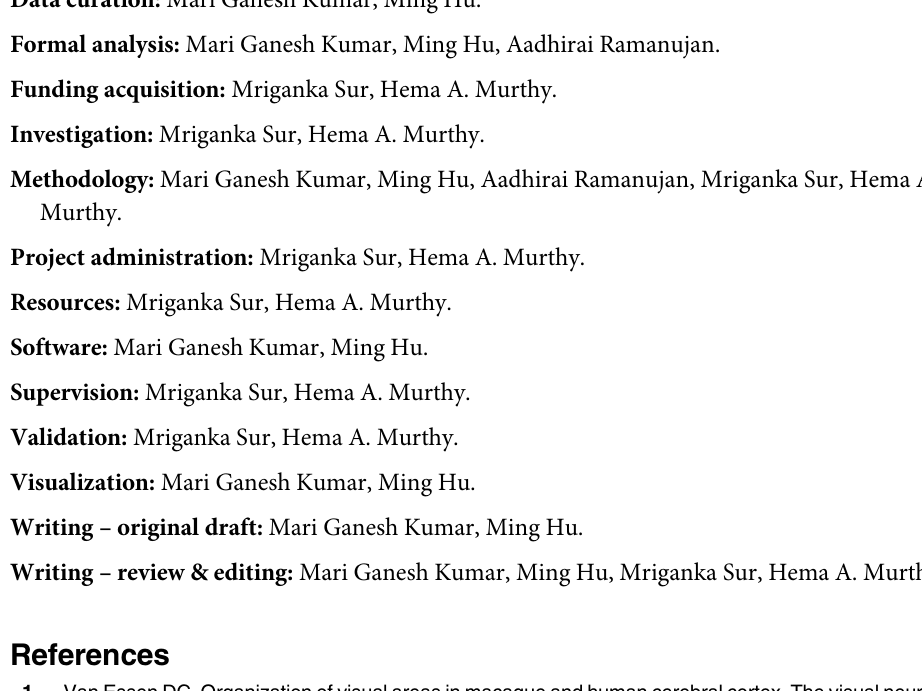
S1 Table. Number of neurons available for other Cre-lines in the Allen Institute dataset. In the text, we analyzed Emx1-IRES and Nr5a1 Cre-lines from dataset 2 (Section 1.2.2). Here we present the number of neurons available from all the other Cre-lines that contain all the six visual areas considered in the paper. S2 Table. Classification accuracy for other Cre-lines in the Allen Institute dataset. In the text, we presented the classification accuracy for Emx1-IRES and Nr5a1 Cre-lines from dataset 2 (Table 4). Here we present the same for all the other Cre-lines in dataset 2 that contain all the six visual areas considered in the